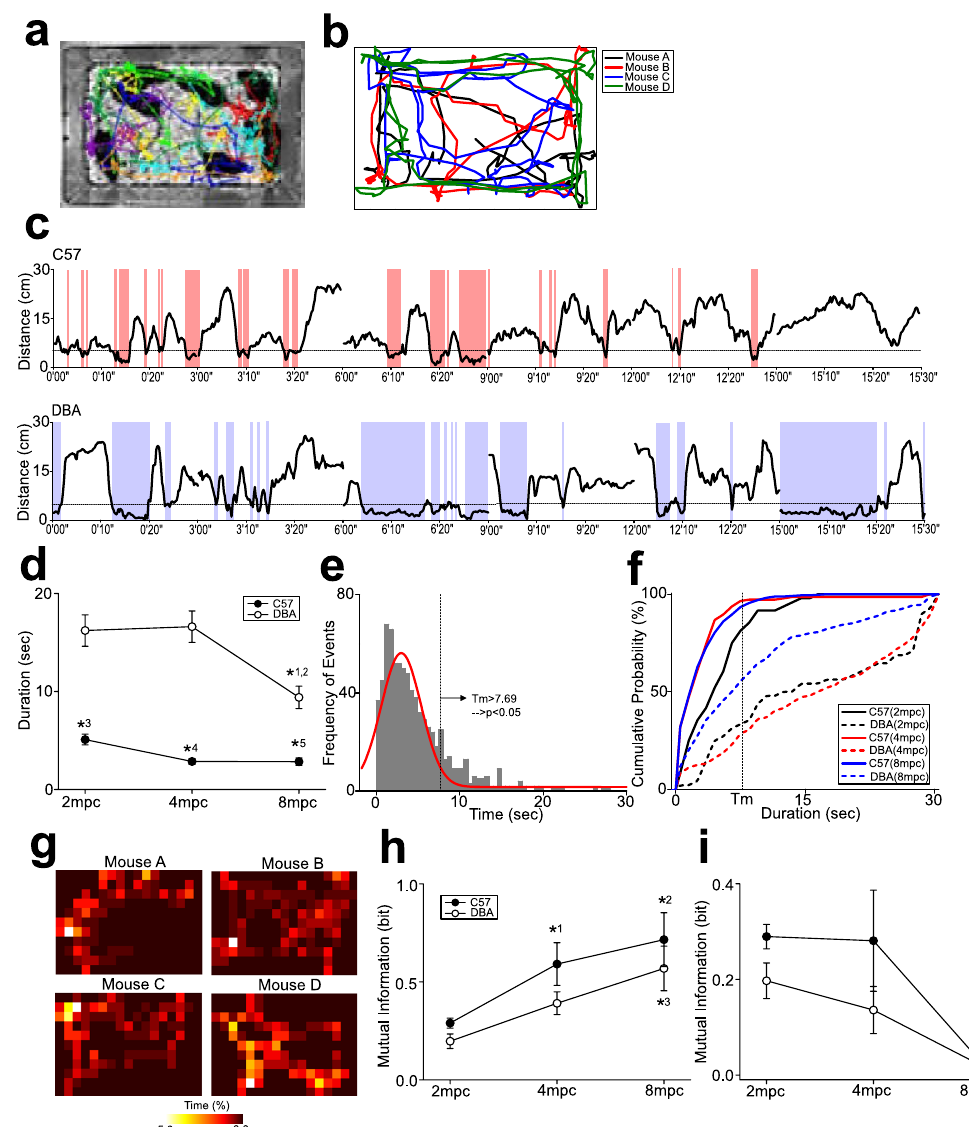
Figure 2. The effects of housing density on social interactions of mice in their home cages. ( a ) A photograph illustrating an example of tracking of mice under the housing condition of 8 mice per cage (8 mpc). ( b ) A diagram illustrating an example of tracking of mice under 4 mpc without backgrounds. ( c ) Diagrams illustrating examples of distance changes between each pair of C57 and DBA mice over time, with 6 times of 30 second recordings in 15 minutes. Red and blue screens indicate the periods in which distance between a pair of mice reached the threshold (i.e. less than 5 cm). ( d ) A graph showing duration of social interactions in C57 and DBA mice under different housing density. * 1 p = 0.034 for 2 mpc vs. 8 mpc in DBA, * 2 p = 0.046 for 4 mpc vs. 8 mpc in DBA, * 3 p < 0.001 for C57 vs. DBA under 2 mpc, * 4 p < 0.001 for C57 vs. DBA under 4 mpc, * 5 p = 0.024 for C57 vs. DBA under 8 mpc. ( e ) A graph showing a normal distribution of duration for the distance reaching less than 5 cm by chance, which was calculated by randomly shuffled pairs of mice. Tm indicates the duration at 2 standard deviations from the mean of the normal distribution, corresponding to statistical significance (p < 0.05). The red line indicates Gaussian curve fitting to the distribution. ( f ) A cumulative histogram for duration of social interactions shown in ( d ), along with Tm shown in ( e ). ( g ) Diagrams illustrating an example of a group of 4 mice for probability of locations that each mouse was observed within the home cage during observations. ( h ) A graph showing the amount of mutual information in each pair of mice. * 1 p = 0.002 for 2 mpc vs. 4 mpc in C57, * 2 p < 0.001 for 2 mpc vs. 8 mpc in C57, * 3 p = 0.006 for 2 mpc vs. 8 mpc in DBA. ( i ) A graph similar to ( h ), but showing the amount of mutual information in whole groups. * p = 0.040 for 2 mpc vs. 8 mpc in